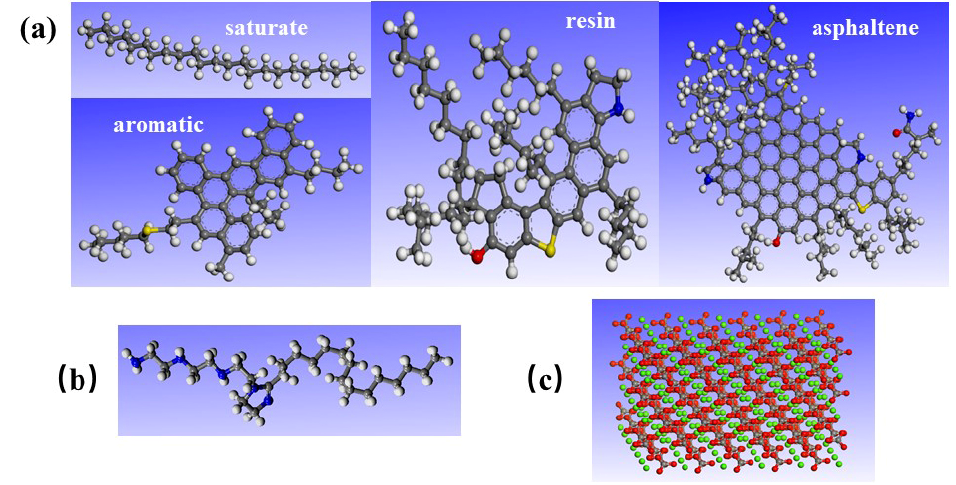
Figure 2. The optimized models: ( a ) asphalt SARA four fractions; ( b ) imidazoline surfactants WMA additives; ( c ) calcite (104)